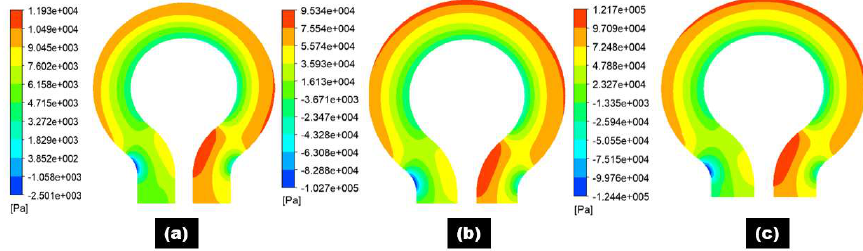
Figure 9. Pressure distribution contours of double offset U−bend for three different flow velocities: ( a ) 2 m/s; ( b ) 4 m/s; ( c ) 6 m /s.